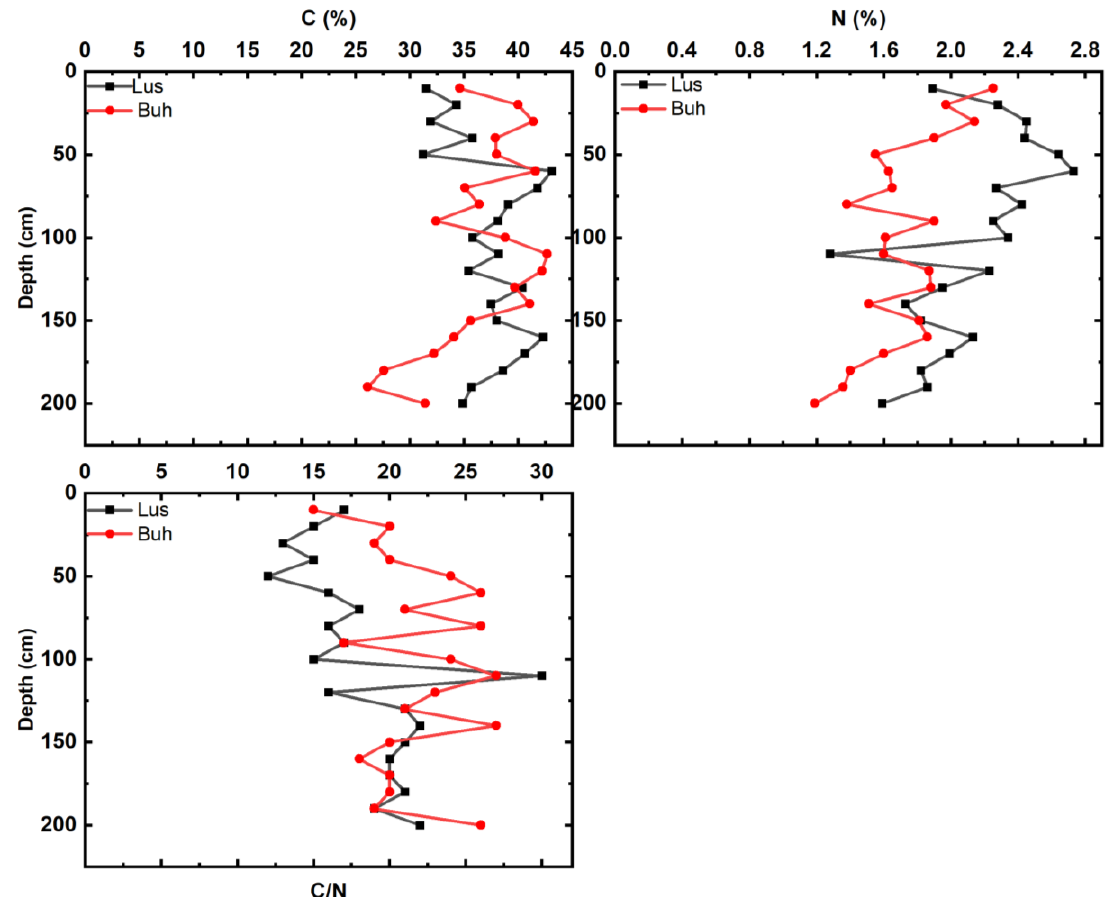
Figure 6. Profiles of C, N and C/N for peat cores from the second (2018) field campaign at Buhandanda (Buh) and Lushala